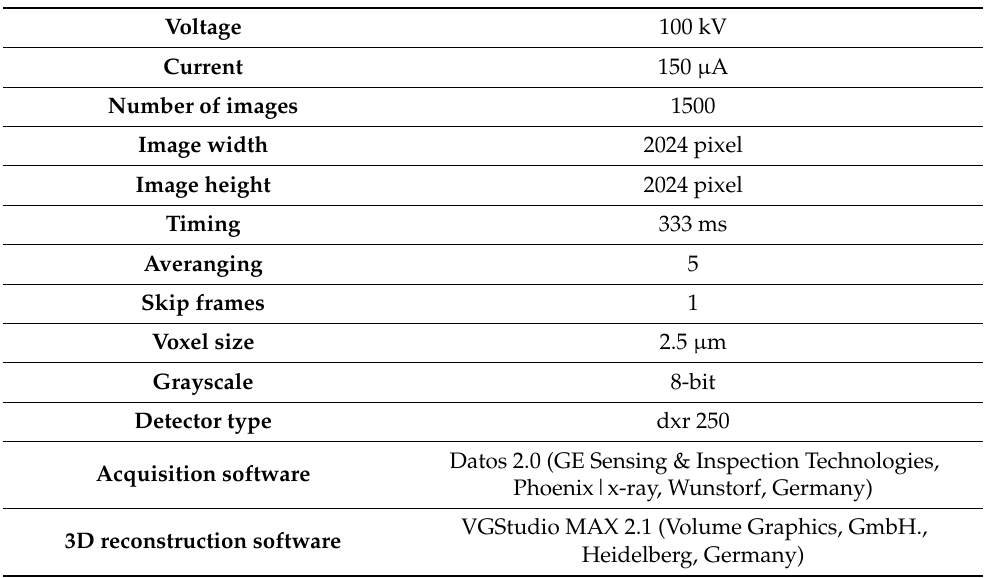
Table 1. Parameters of microtomographic scans and used